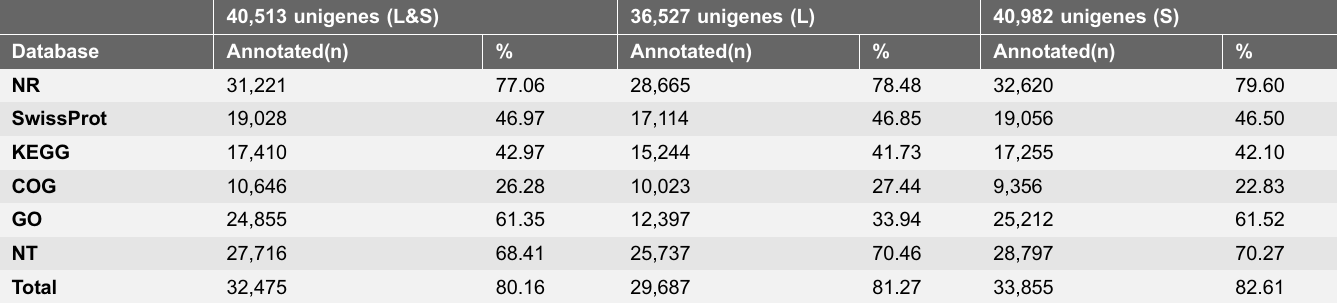
Table 2. Summary of functional annotation of assembled unigenes.